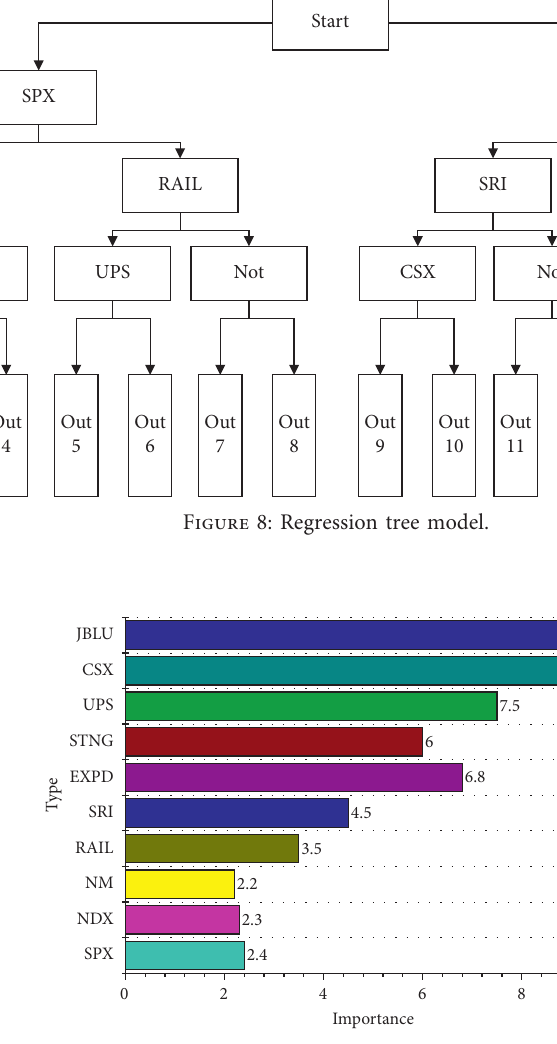
Figure 9: Importance of lifting tree diagram.